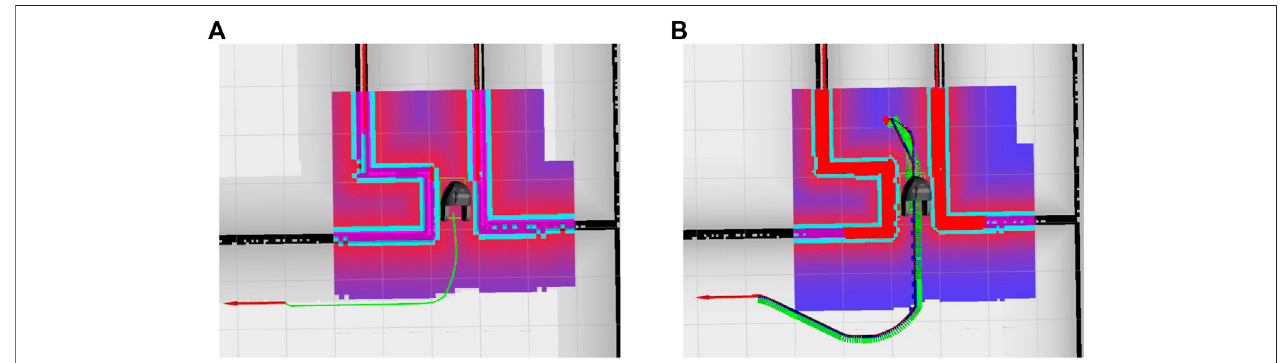
FIGURE 2 | (A) Dijkstra planner wants the robot to turn on the spot in a tight corridor; (B) SBPL planner drives the robot to a location with enough space to turn